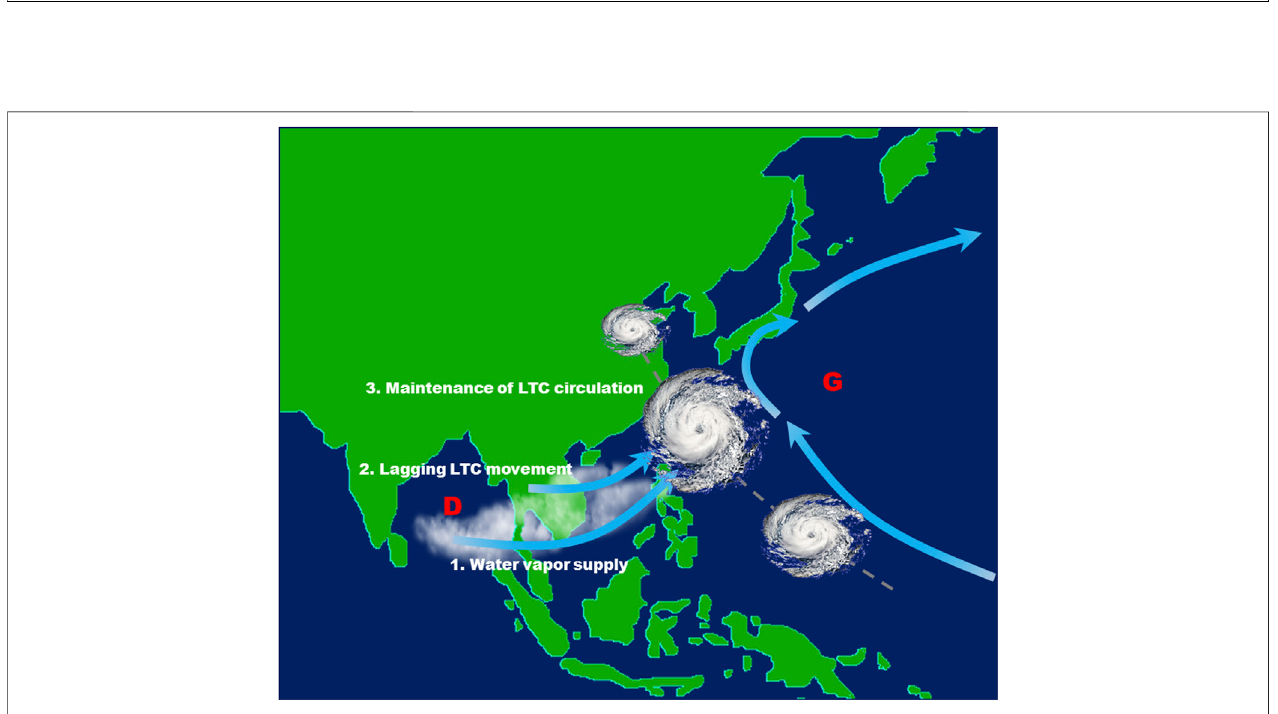
FIGURE 12 | Conceptual model for the in fl uence of the monsoonal surge on ERLTCs. The thick blue arrows represent the directions of the air fl ow; G and D representthehighpressureandlowpressureassociatedwiththeanticycloniccirculationandcycloniccirculation,respectively;thegreydashedlineindicatesthetrackof the TC; and the cloud cluster to the southwest of the TC indicates the activity of the monsoonal surge.